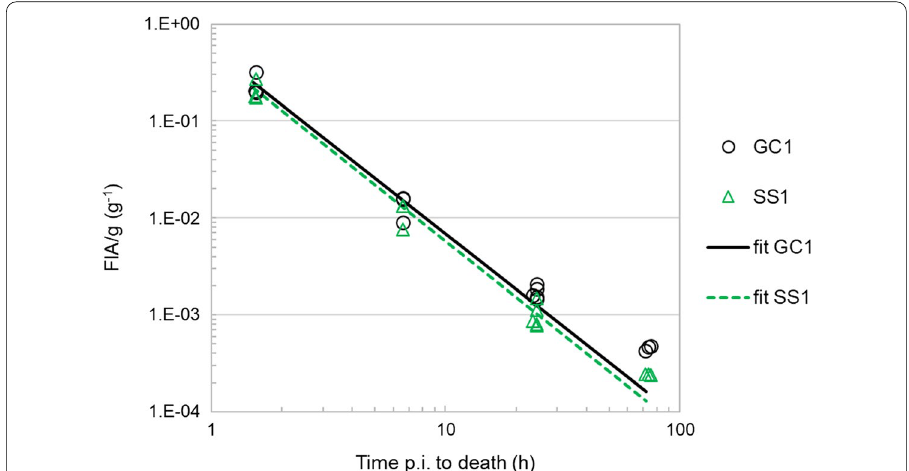
Fig. 6 Time– FIA / g data of the left kidney determined with SPECT (dataset SS1) and with GC (dataset GC1), of 14 mice injected with the [ 131 I]-labelled sdAb. The curves indicate the power function fit of each dataset (cfr. function coefficients in Table 4)